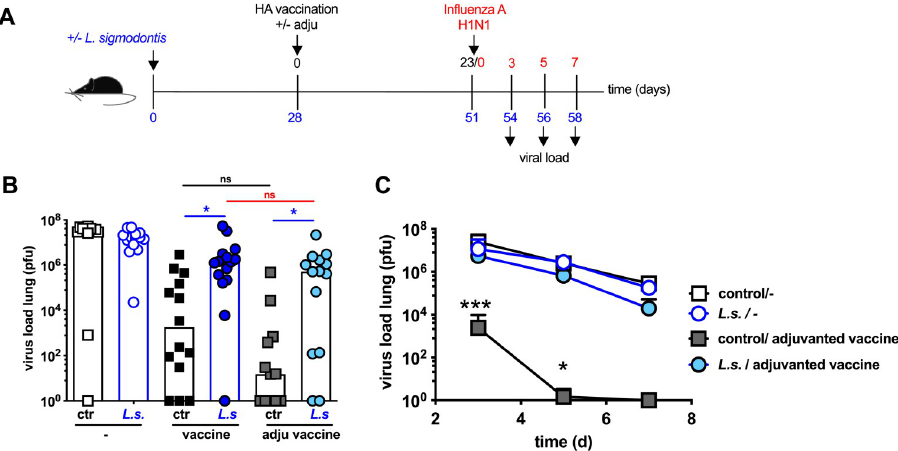
Fig 3. Adjuvanted influenza vaccination does not protect L . sigmodontis -infected mice from influenza virus replication in the lung. (A) Experimental design: C57BL/6 mice were left naive (black and grey squares) or naturally infected with L . sigmodontis (light and dark blue circles). Mice either received a control injection (open symbols) or were i.p. vaccinated with non-adjuvanted influenza vaccine Begripal season 2017/18 (black squares, dark blue circles) or adjuvanted influenza vaccine Fluad season 2017/18 (grey squares, light blue circles) at day 28 post L . sigmodontis infection. All mice were i.n. infected with 1 x 10 3 PFU 2009 pH1N1 influenza A virus 2 days later. Influenza virus burden in the lung was quantified day 3 post challenge infection (B) or at indicated time points (C) . Shown are combined results out of 2 independent experiments with n � 4 per group and experiment. (B) Each symbol represents an individual mouse the lines show the mean. Asterisks indicate statistically significant differences applying 1-way ANOVA (p > 0.001) with Tukey’s multiple comparison test comparing all vaccinated groups with each other. Numbers indicate p-values, ns = not significant, � p � 0.05, �� p � 0.01, ��� p � 0.001; black asterisks: na ï ve control non-adjuvanted vaccine group to na ï ve control adjuvanted vaccine group, blue asterisks: L . sigmodontis -infected non- adjuvanted and adjuvanted vaccine groups to na ï ve control non-adjuvanted or adjuvanted vaccine groups, red asterisks: L . sigmodontis -infected non-adjuvanted to L . sigmodontis -infected adjuvanted vaccinated groups. (C) Symbols show the mean per group at the indicated time point, error bars show SD. Asterisk indicated differences between the na ï ve control adjuvanted vaccine group and the L . sigmodontis -infected adjuvanted vaccine group applying 2-way ANOVA with Sidak‘s multiple comparison